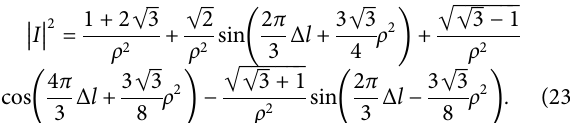
FIGURE 3 | Two off-axis Gaussian vortex structures.